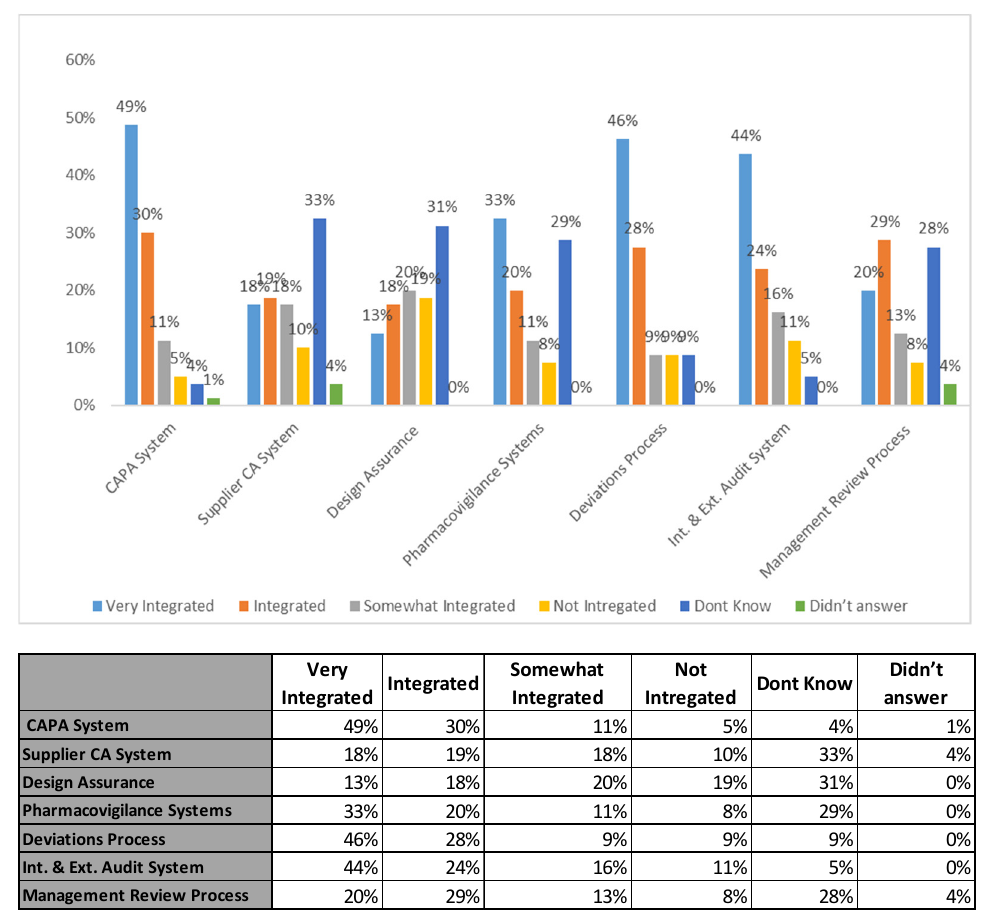
Figure 4. Integration of CI into pharmaceutical QMS processes and other various func- tions.